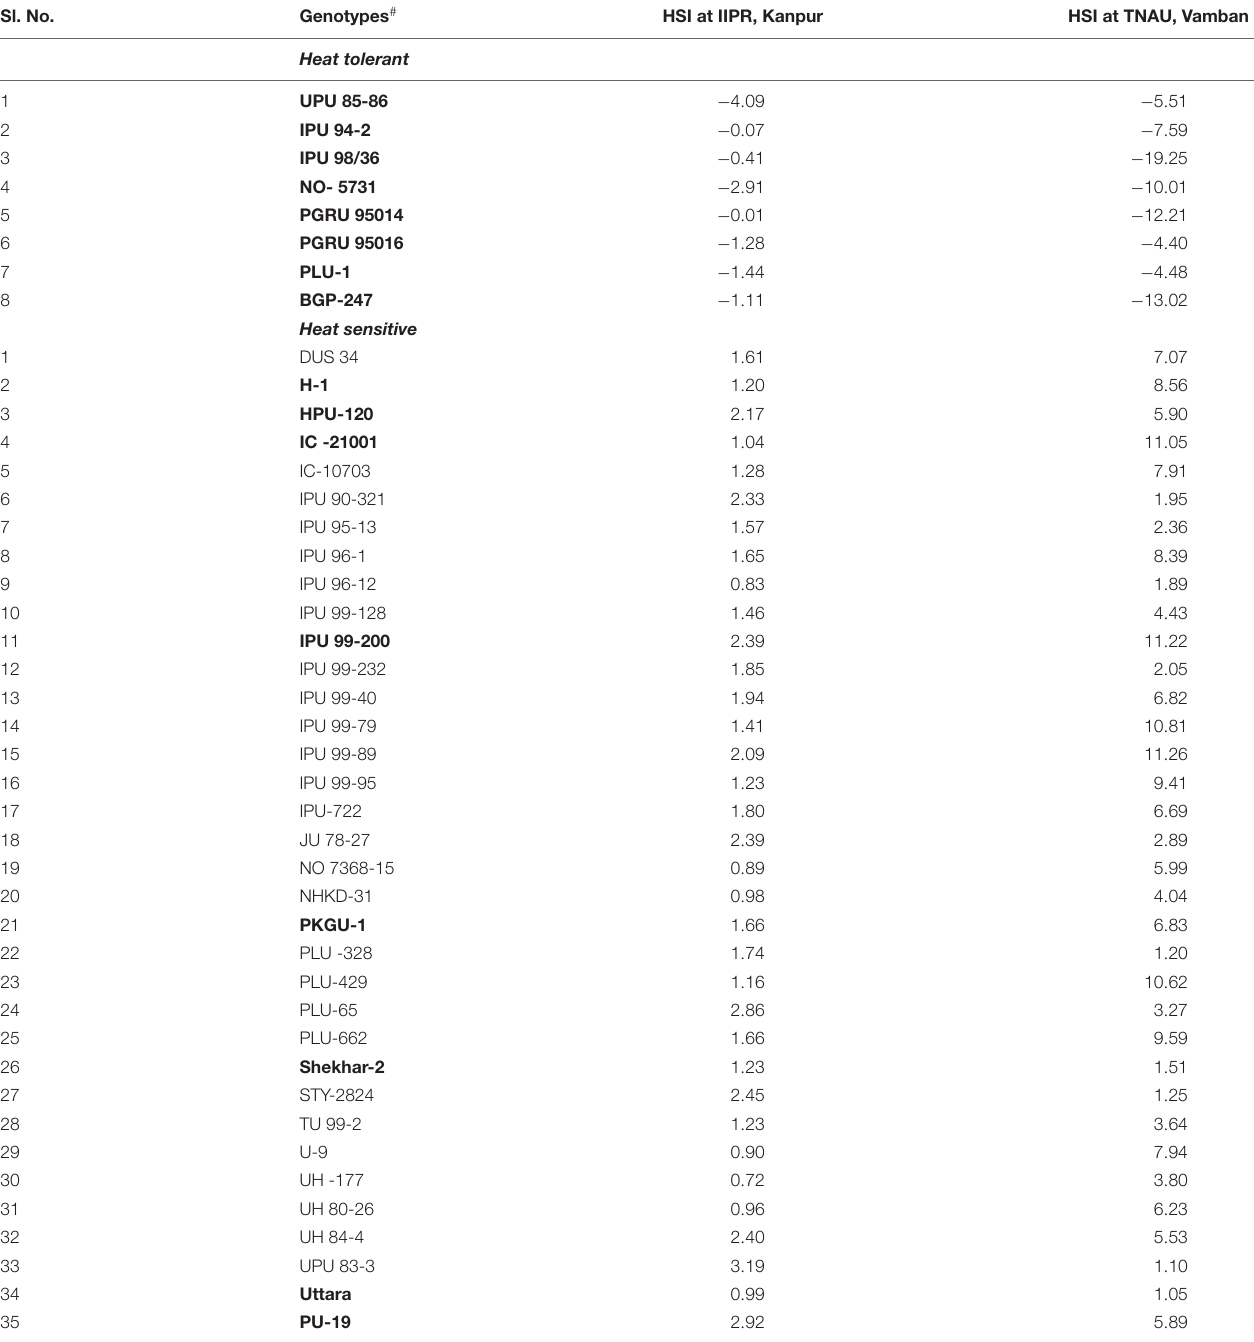
TABLE 4 | Heat-tolerant and heat-sensitive urdbean genotypes over both the locations (IIPR, Kanpur and TNAU, Vamban) based on HSI. Sl. No. HSI at IIPR, Kanpur HSI at TNAU,